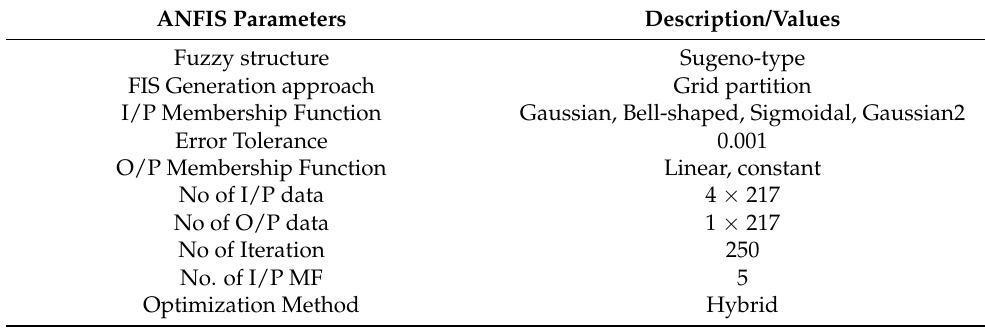
Table 4. Parameters for tuning ANFIS